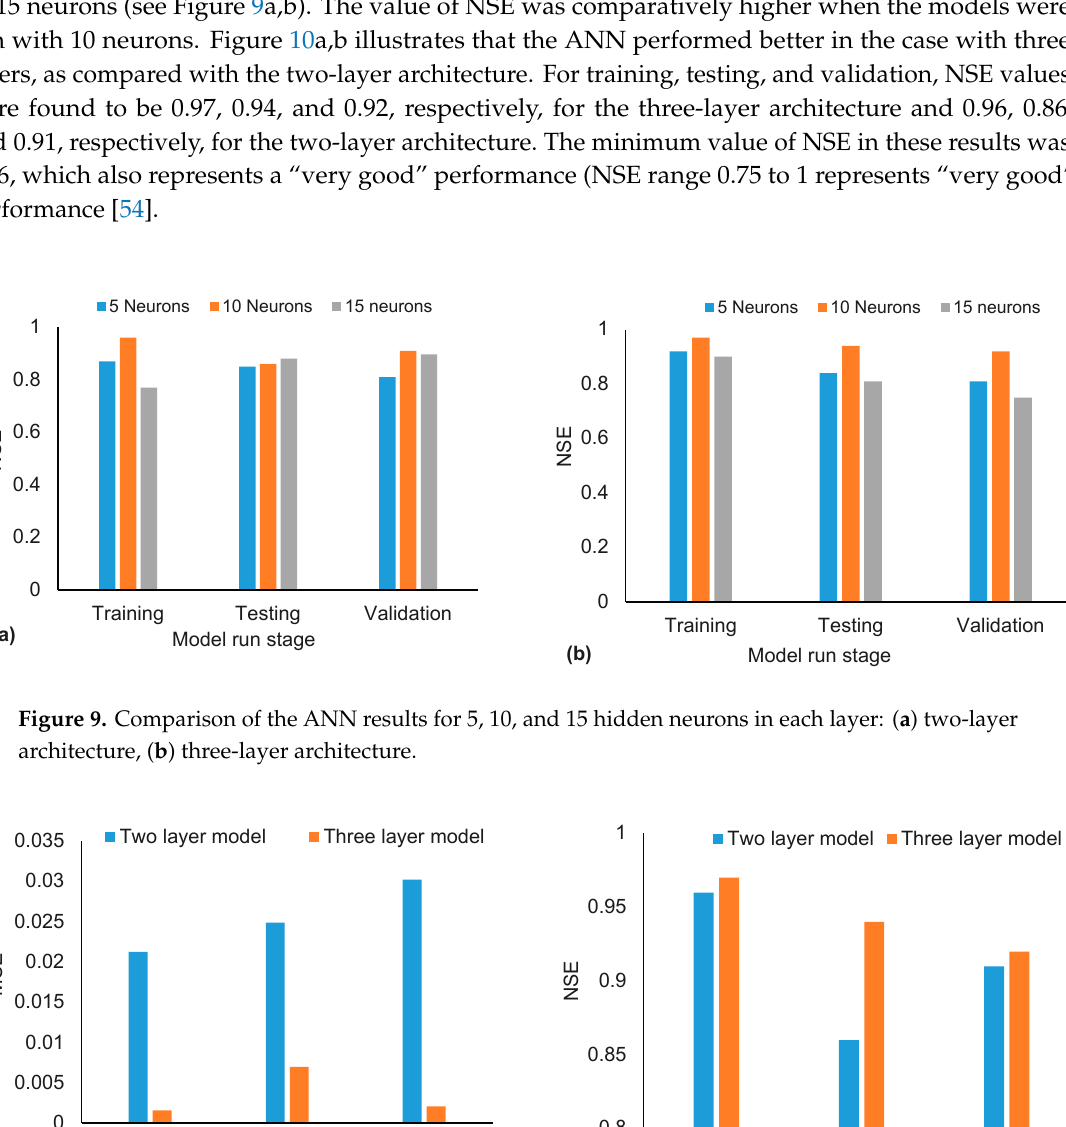
Figure 8. ANFIS Results for groundwater modeling; ( a ) Performance indicator, ( b ) Predicted verses observed groundwater levels.